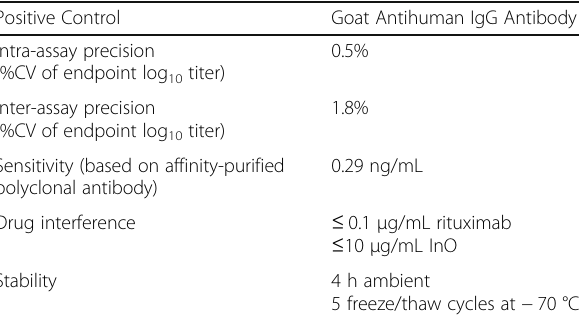
Table 6 Anti-rituximab antibody assay validation characteristics Positive Control